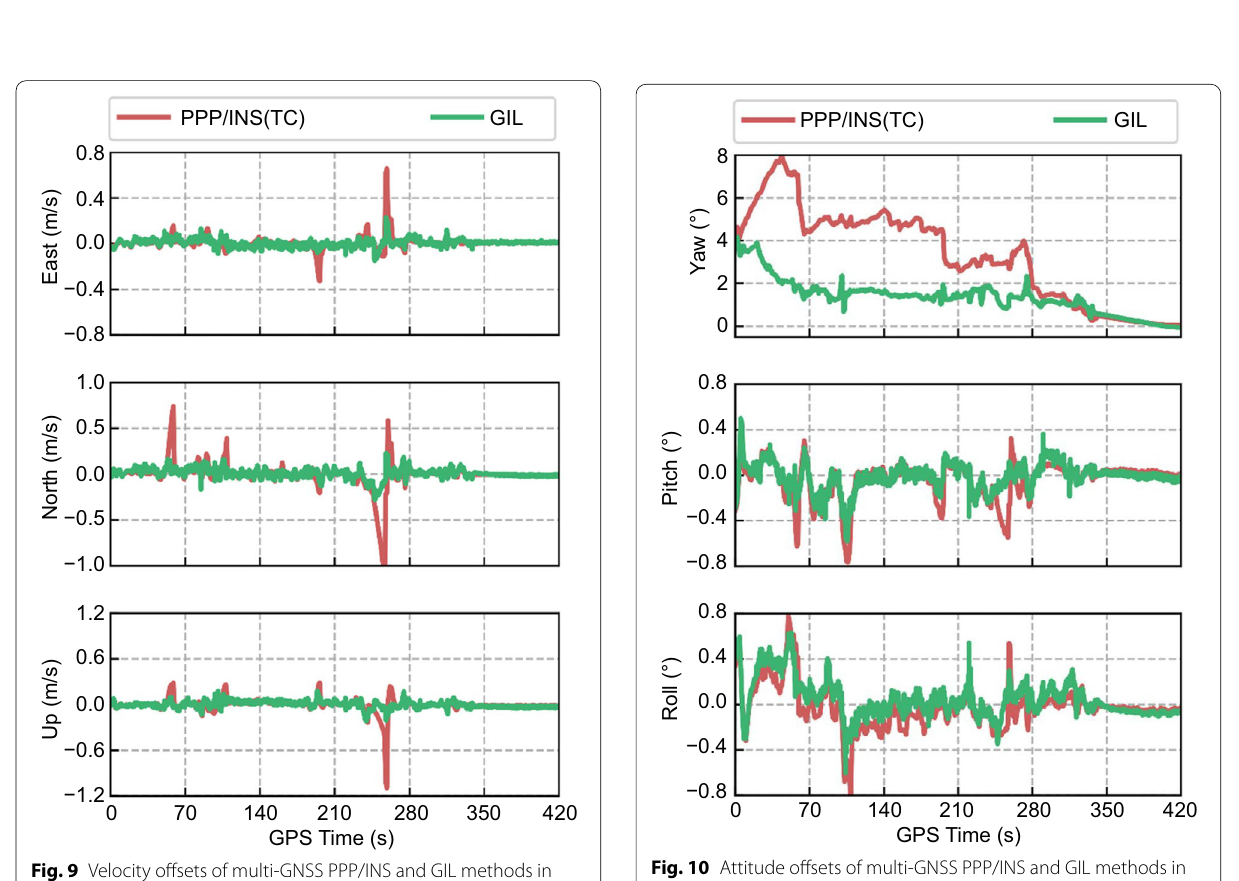
Fig. 9 Velocity offsets of multi-GNSS PPP/INS and GIL methods in GNSS partly-blocked experiment